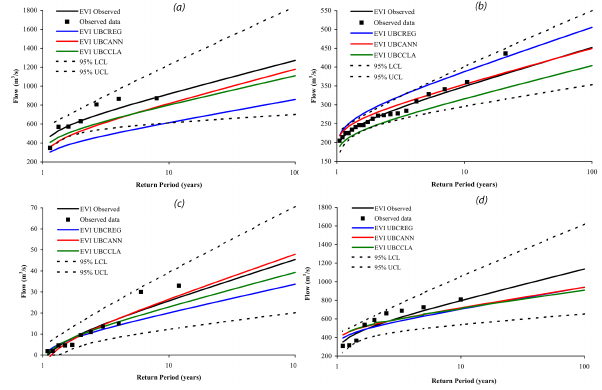
Figure 9. Flood frequency estimation for the (a) Upper Campbell, (b) Illecillewaet, (c) Yermasoyia, and (d) Astor watersheds.